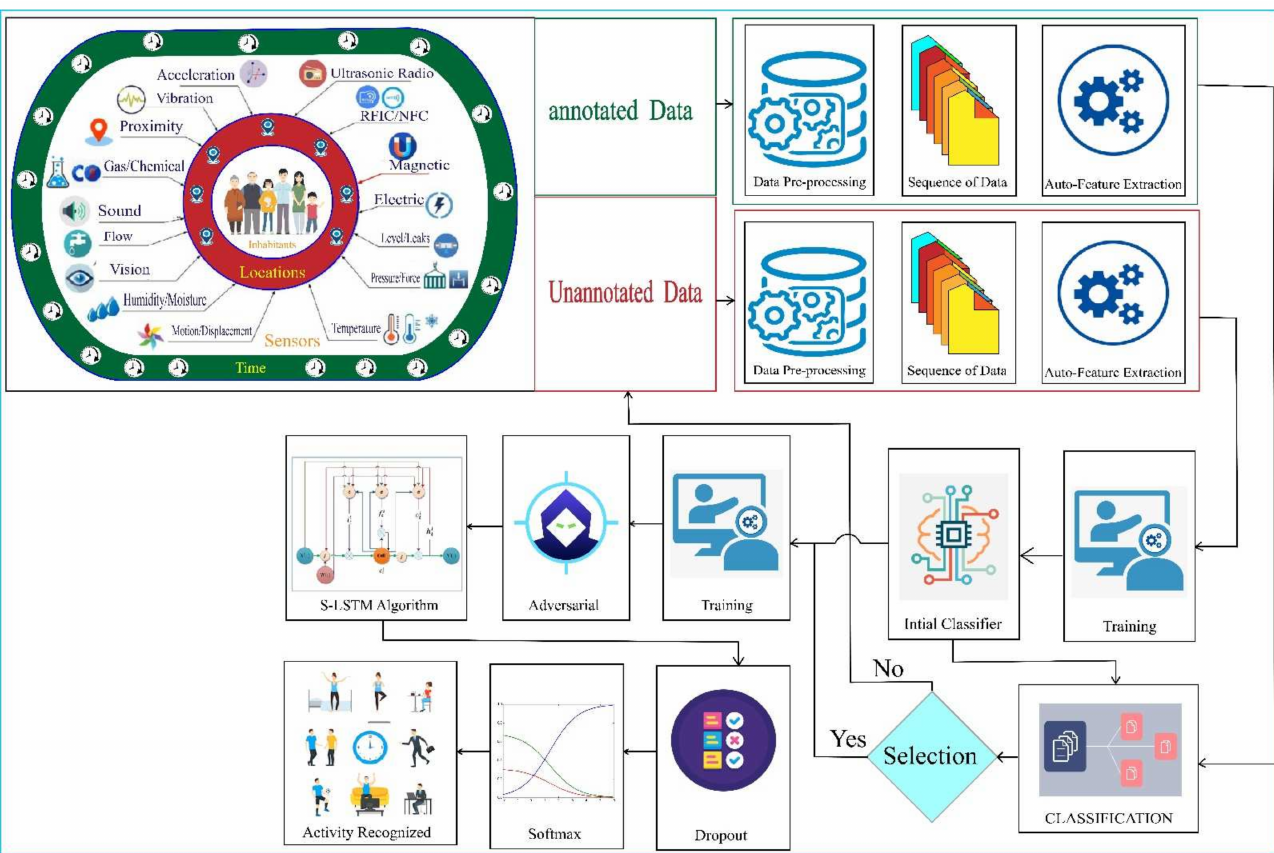
Figure 1. System workflow of our proposed method for